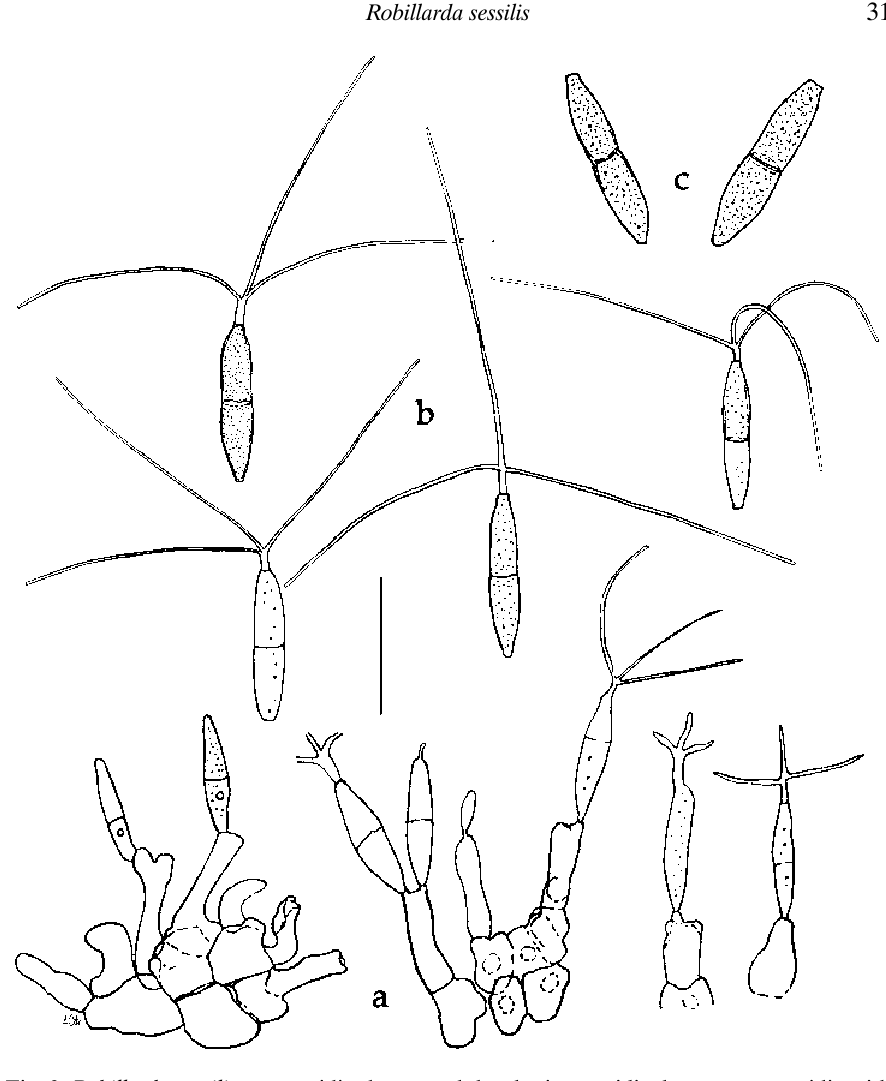
Fig. 3. Robillarda sessilis : a – conidiophores and developing conidia, b – mature conidia with appendages, c – conidia that lost apical cell MSK 7065. Scale bar = 10